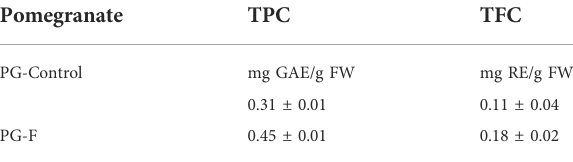
TABLE 3 Total phenolic and total fl avonoid